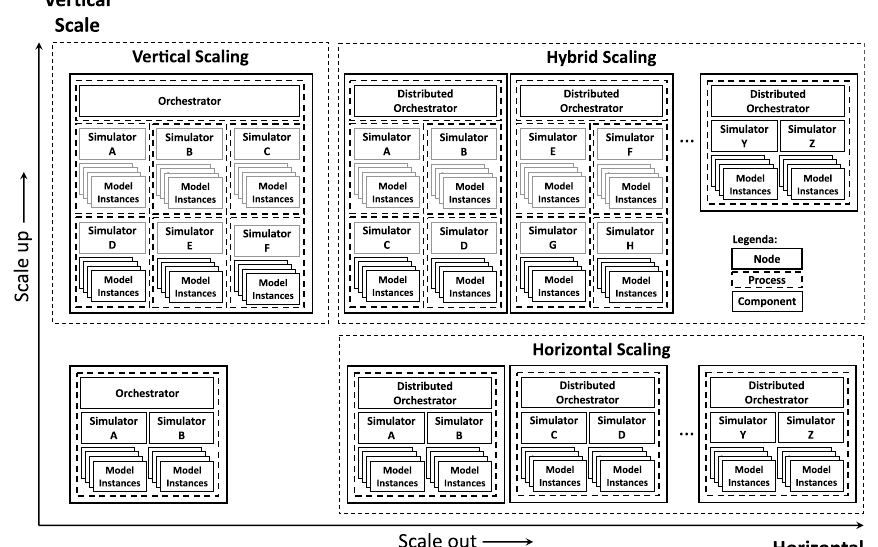
Fig. 3 Vertical and horizontal